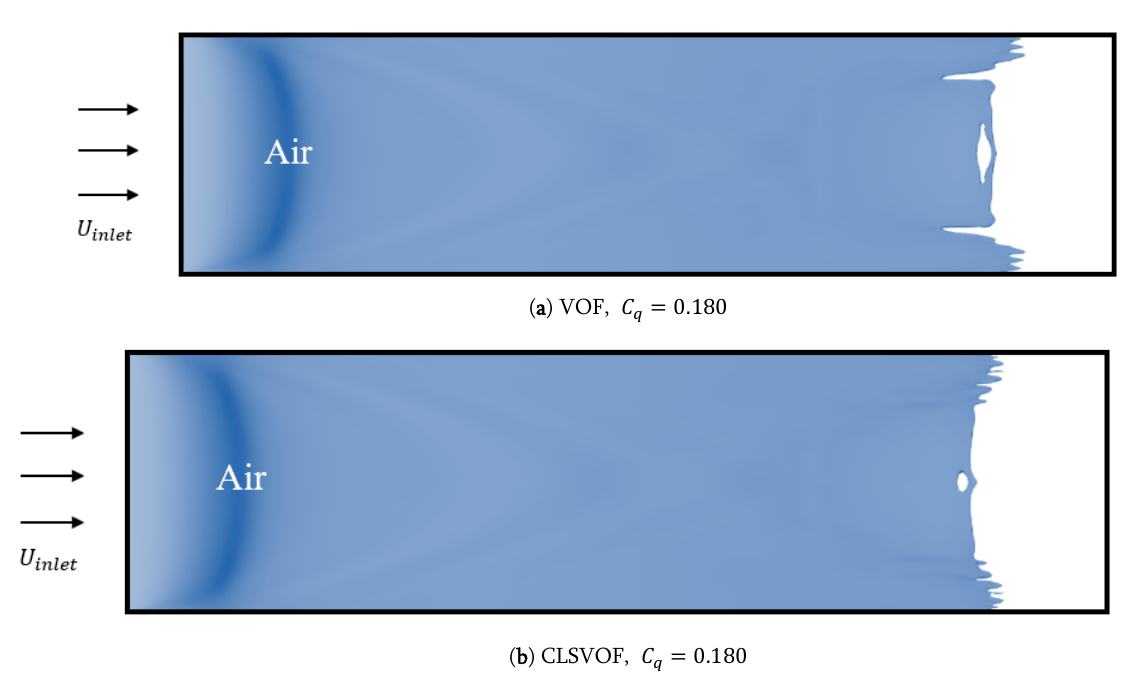
Figure 16. Air layer shape according to CLSVOF and VOF solvers at C q = 0.180.